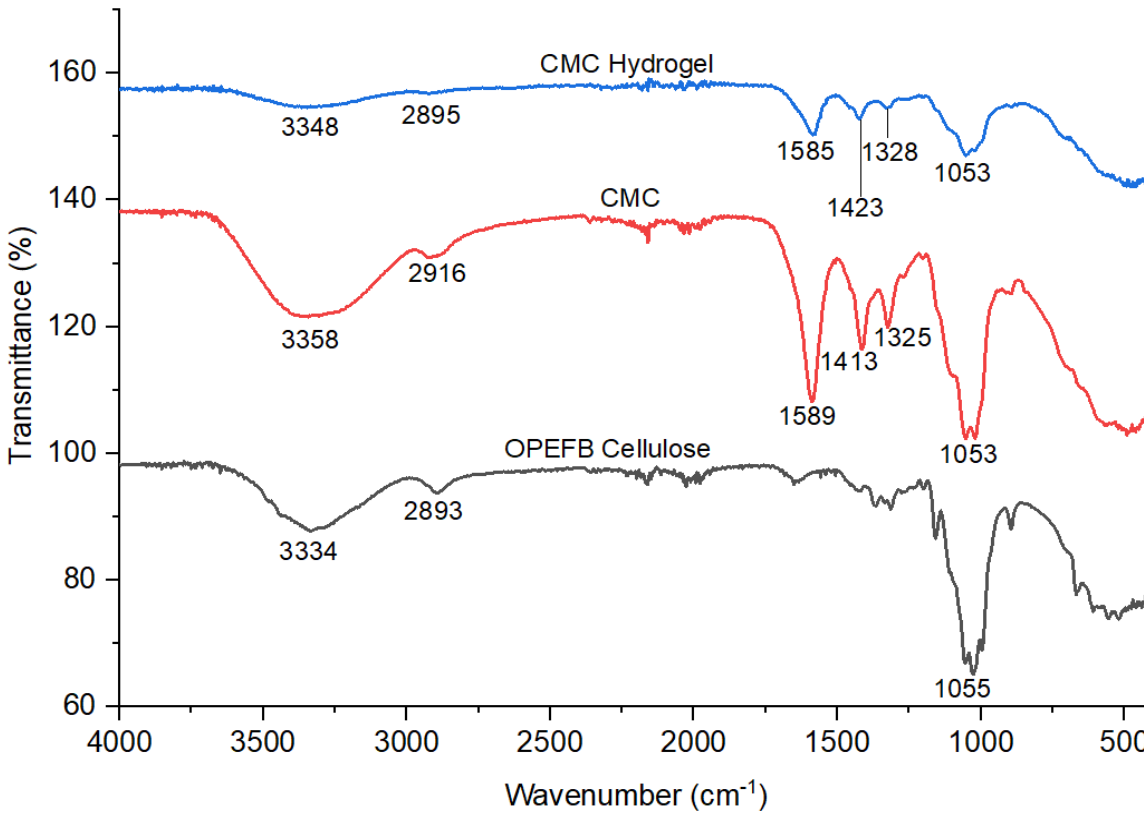
Figure 8. FT-IR spectra of OPEFB cellulose, CMC, and CMC hydrogel.